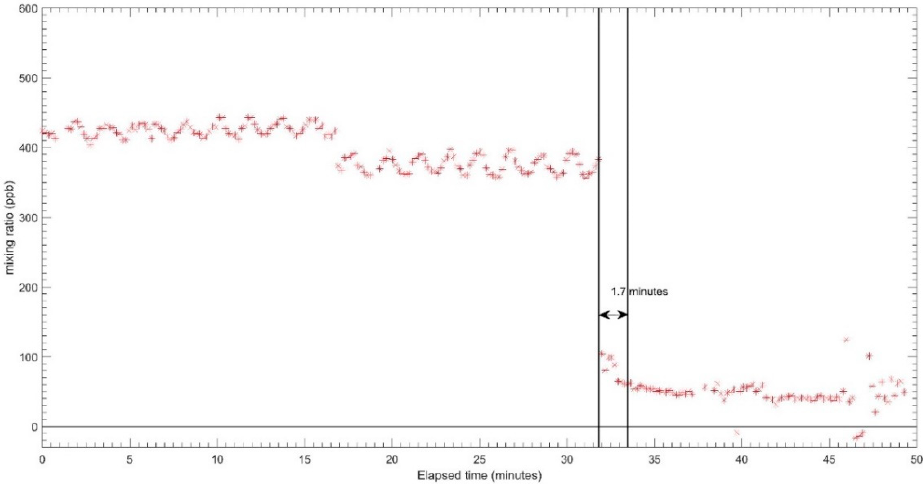
Figure 6. Response time of OX-A431 sensor from target gas to zero.